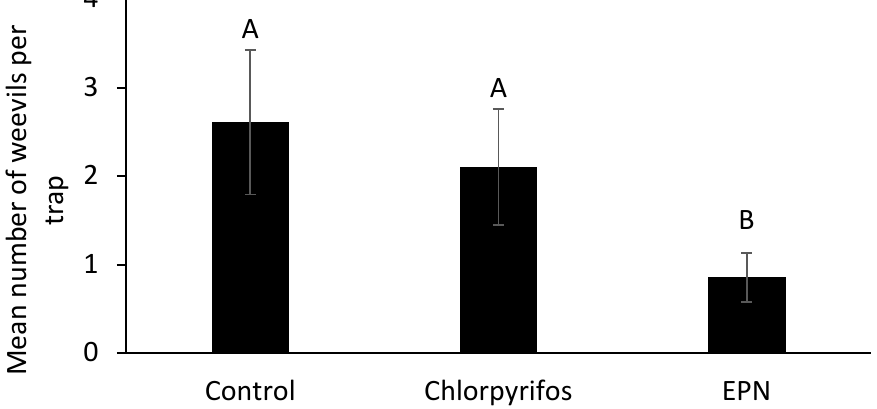
Figure 6. Average weevil catch per week. EPN = treatment containing entomopathogenic nematodes, Steinernema carpocapsae . A combination of all species of weevil caught from May 2019 to May 2020. Different letters at the top of bars indicate significant differences ( p < 0.05).